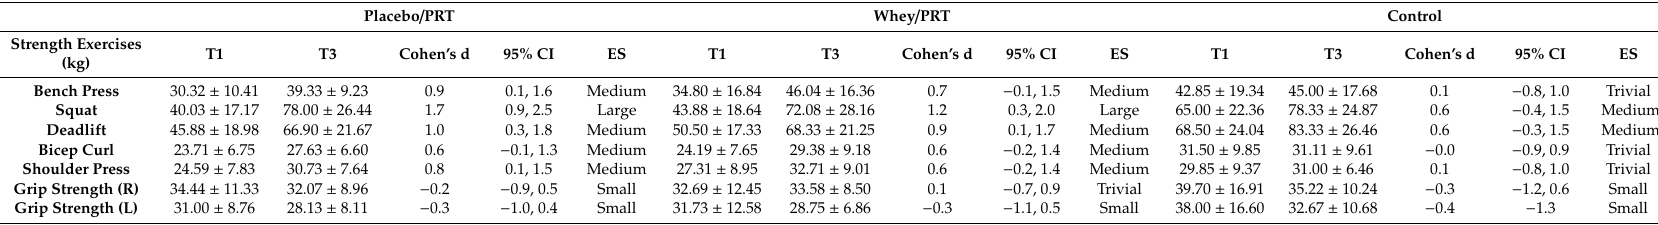
Table 4. E ff ect sizes (ES) of one-repetition maximum (1RM) strength indices from T1 to T3 in the placebo / PRT, whey / PRT, and control in HIV-infected individuals receiving ART (Mean ± SD). Placebo / PRT Whey / PRT Control